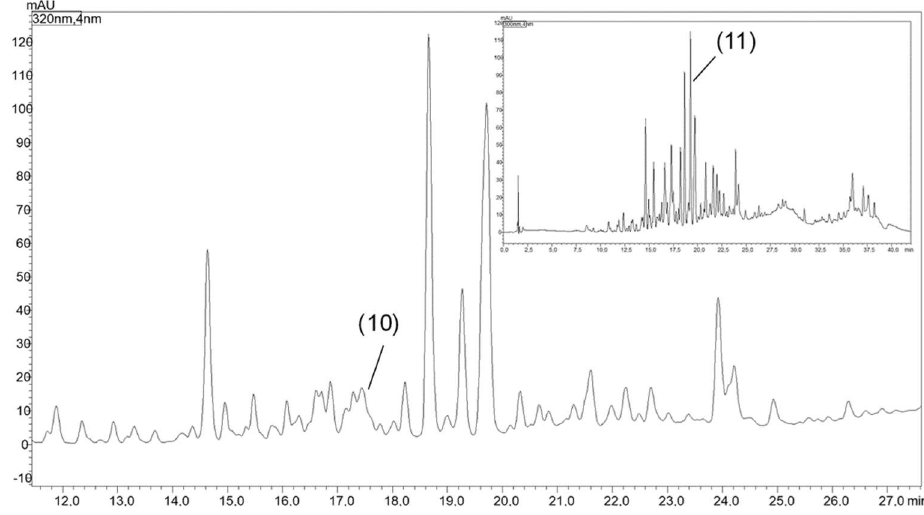
Figure 2. Chromatographic profile of the red propolis extract, kaempferol (10) and formononetin (11) (sample E:50−20).